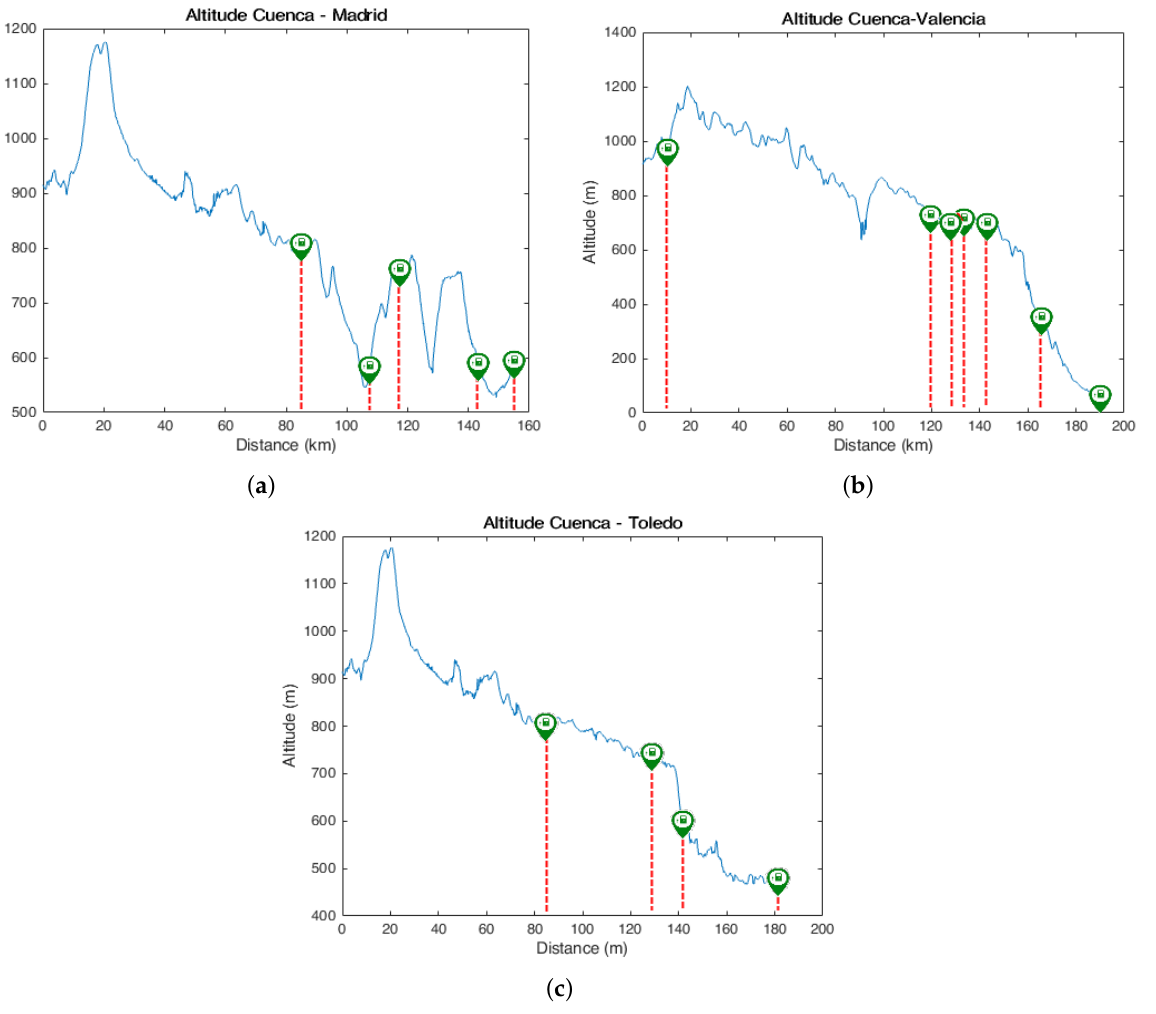
Figure 7. Altitude profile and charging stations on the routes: ( a ) Cuenca–Madrid, ( b ) Cuenca– Valencia, and ( c )